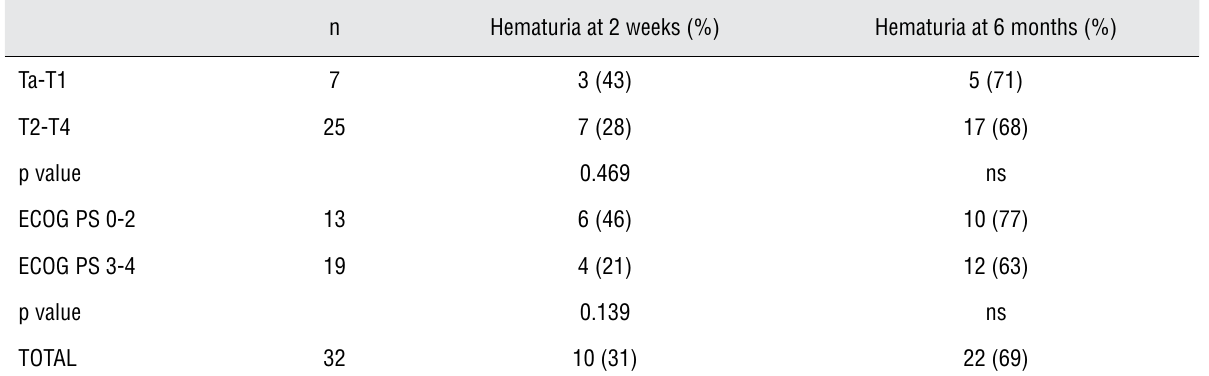
Table 5 - Results at 2 weeks and 6 months.